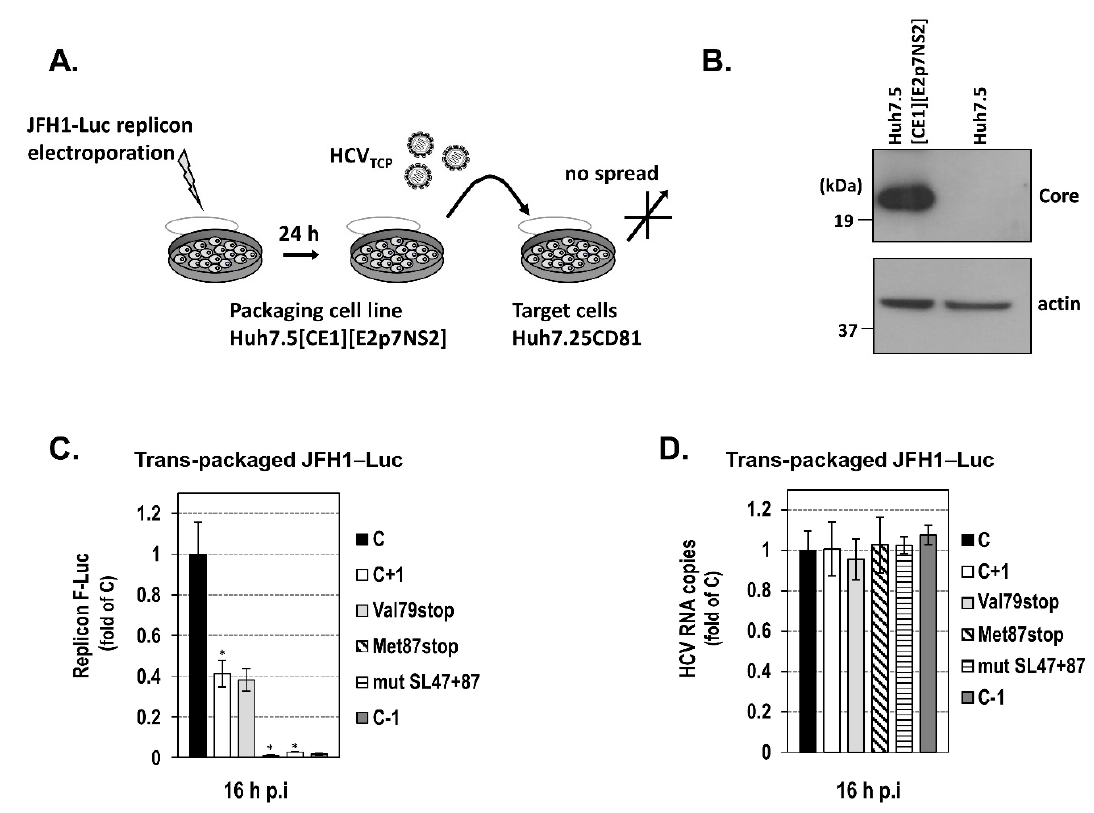
Figure 6. Core + 1 / S expression in the context of JFH1 replicon after infection with trans-complemented (TCP) viral particles. ( A ) Experimental setup to create trans-complemented HCV particles (HCV TCP ) encapsidating subgenomic JFH1-Luc replicons in the stable cell line Huh7.5[CoreE1][E2p7NS2]. ( B ) Analysis of the CoreE1 transgene expression in electroporated with the JFH1-Luc replicon packaging cellsbyWesternblottingusingHCVcore-andactin-specificantibodies. ( C , D